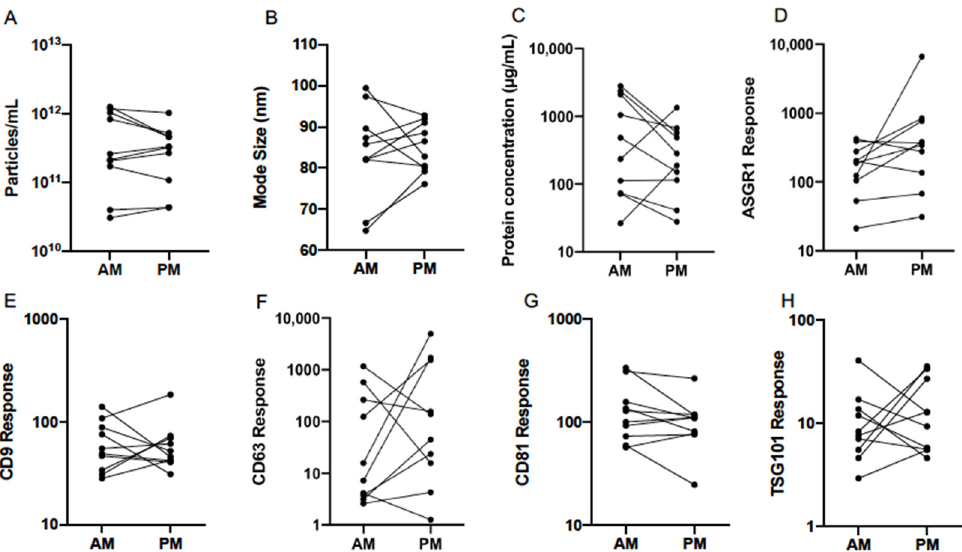
Figure 3. Variability of serum EV particle abundance ( A ), size ( B ), total protein concentration ( C ), and expression of EV-associated protein markers ( D – H ), quantified by nanoparticle tracking analysis (NTA), microBCA assay, and liquid chromatography mass spectrometry (LCMS) in the morning (AM) and afternoon (PM) of study day 1 in healthy volunteers ( n = 10). ASGR1: asialoglycoprotein receptor 1; CD: cluster of differentiation; TSG101: tumour suppressor gene 101. Table 2. Geometric mean, 95% confidence interval (CI), minimum and maximum of particle count, mode size, total protein concentration, and EV-associated protein marker abundance quantified in EVs isolated in the morning and afternoon on study day 1 from serum of healthy volunteers ( n = 10).